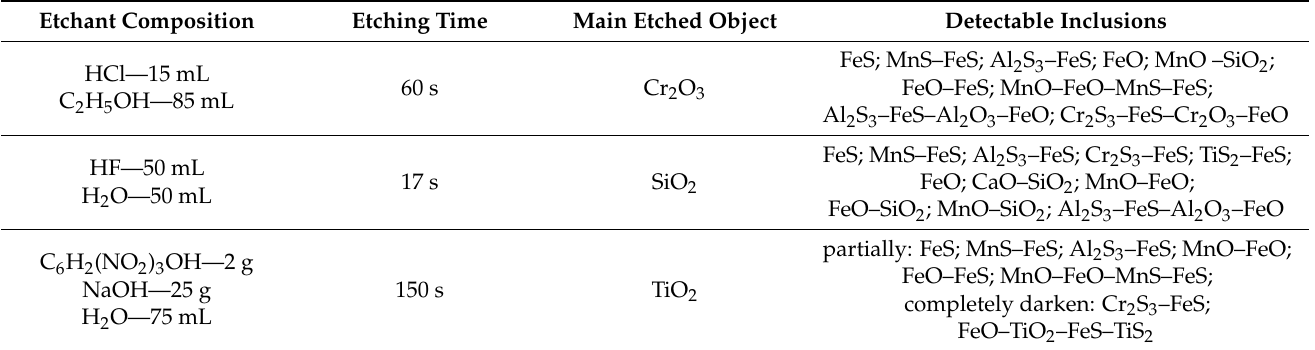
Table 3. Used etchants.